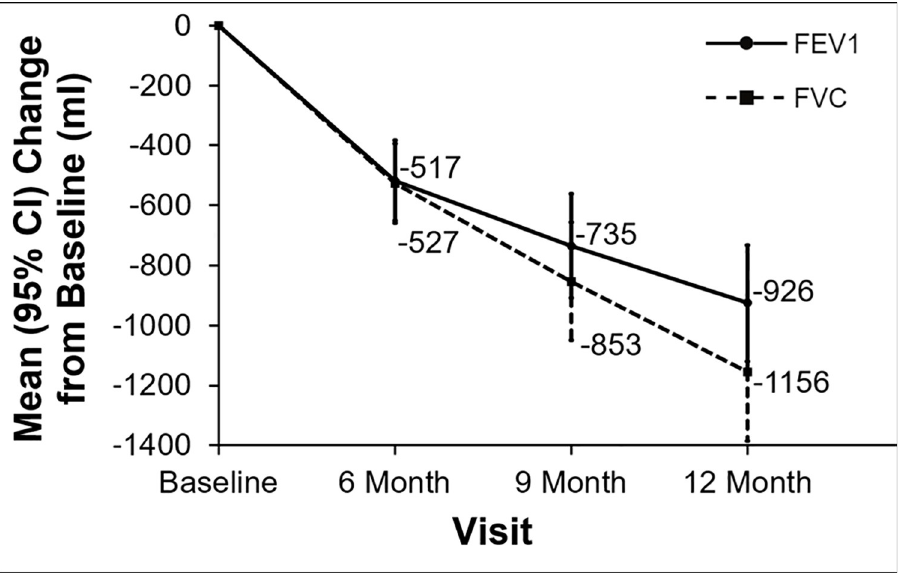
Fig 4. Pulmonary function during observation–PFT = 0 for death and sum of squared differences for other reasons of missing values method of imputation (used in CAPACITY trials). FEV 1 –forced expiratory volume in 1 second, FVC- forced vital capacity, ml–milliliters, CI–confidence